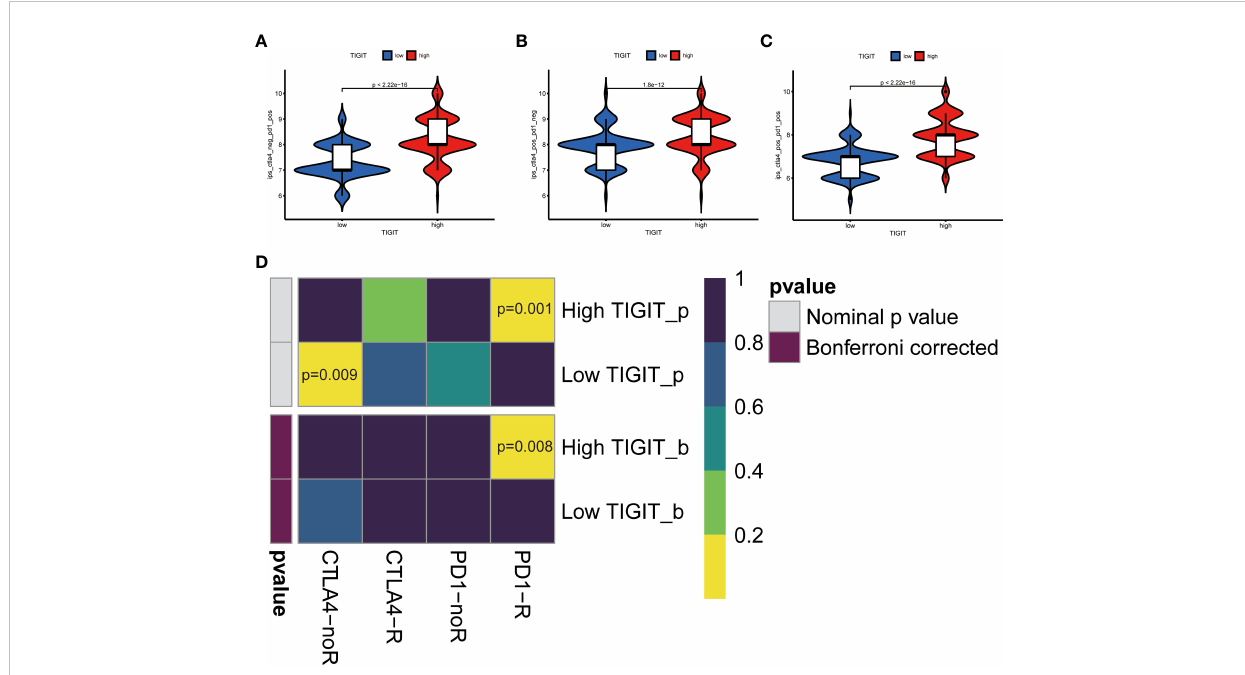
FIGURE 9 TIGIT and response of immunotherapy. (A) Prediction of immunotherapy in CTLA4 negative PD1 positive patients with high/low TIGIT expression. (B) Prediction of immunotherapy in CTLA4 positive PD1 negative patients with high/low TIGIT expression. (C) Prediction of immunotherapy in CTLA4 positive PD1 positive patients with high/low TIGIT expression. (D) Prediction of response to anti-PD1 or anti-CTLA4 immunotherapy by submap in KIRC patients with high/low TIGIT expression.